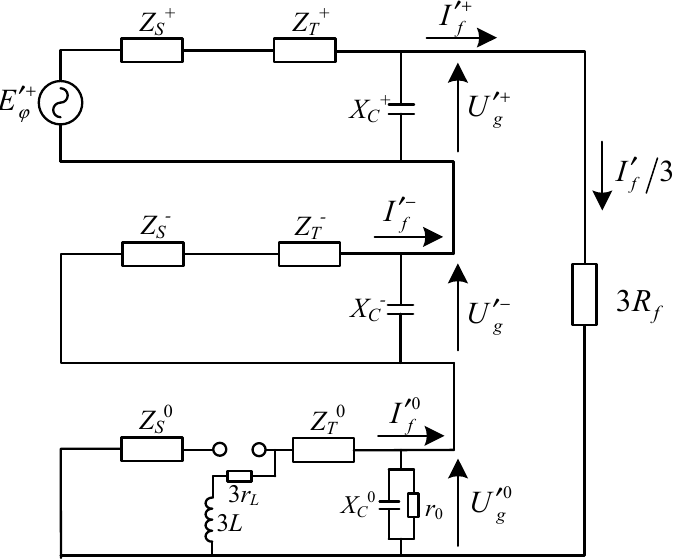
Figure 2. Composite sequence network of a phase-to-ground fault. X C + , X C − and X C 0 , respectively, are the system’s capacitive reactions of the positive-sequence, negative-sequence and zero-sequence. U (cid:48) + g , U (cid:48)− g and U (cid:48) 0 g , respectively, are equivalent three-sequence voltage sources at the fault point. I (cid:48) + f , I (cid:48)− f and I (cid:48) 0 f are the three-sequence fault currents at the fault point, respectively. Z S + , Z S − and Z S 0 , respectively, are the three-sequence equivalent impedances of the distribution system feeders. Z T + , Z T − and Z T 0 are the positive-sequence, negative-sequence and zero-sequence impedances of the HV/MV transformer, respectively. E (cid:48) ϕ + is the positive sequence power electromotive force of the distribution system.